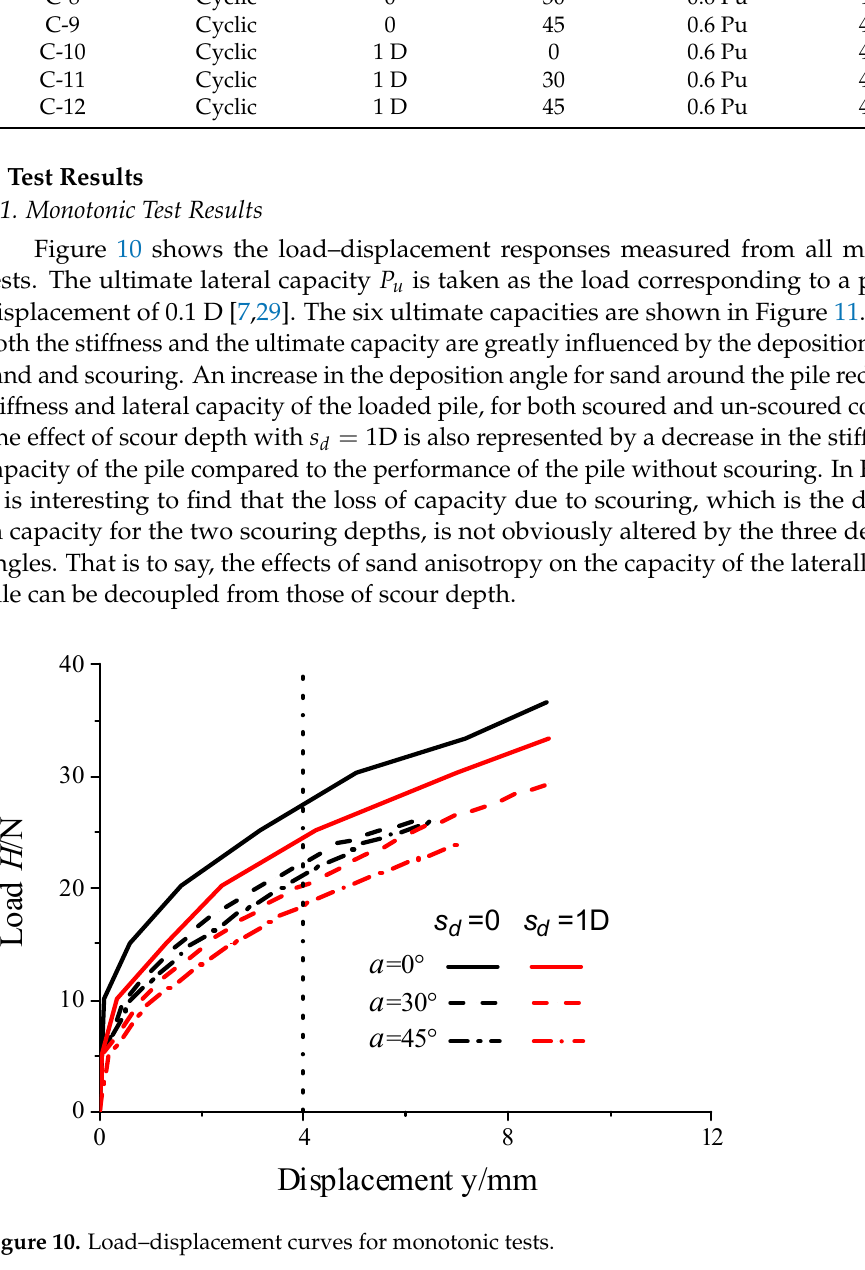
Figure 11. Variation of capacity to deposition angle α .